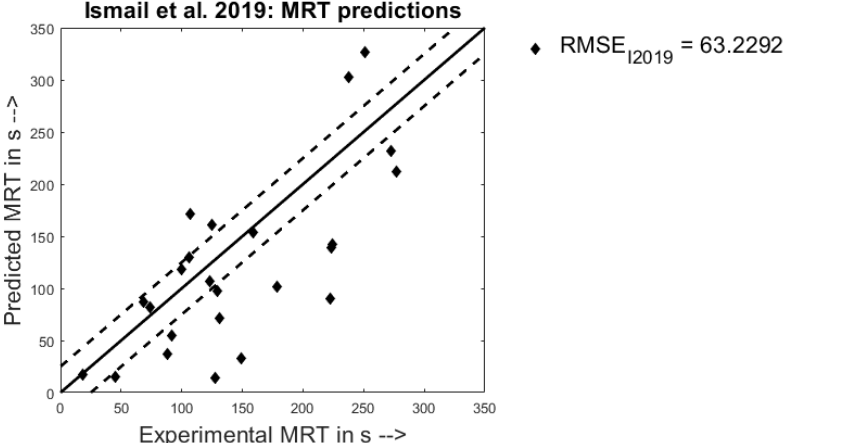
Figure 11. Experimental MRT observations (X) vs. predicted model MRT responses (Y) when trained on the Ismail et al. 2019 [14]